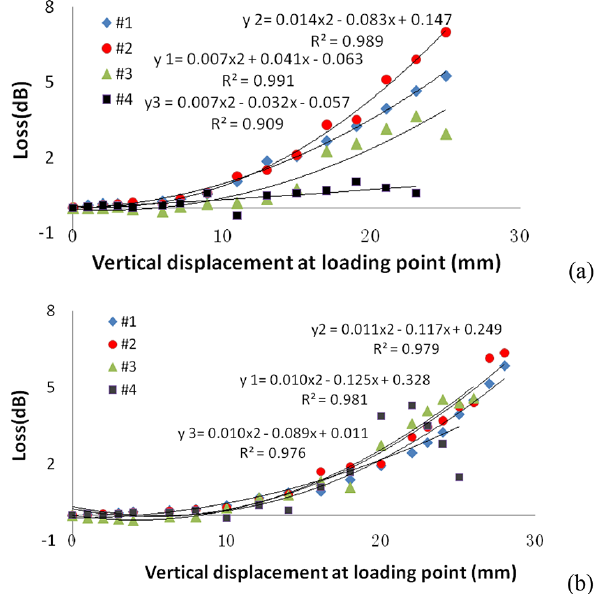
Figure 6. Relationship between fiber optical loss and vertical dis- placement at loading point. (a) Model 3, (b) model 4.